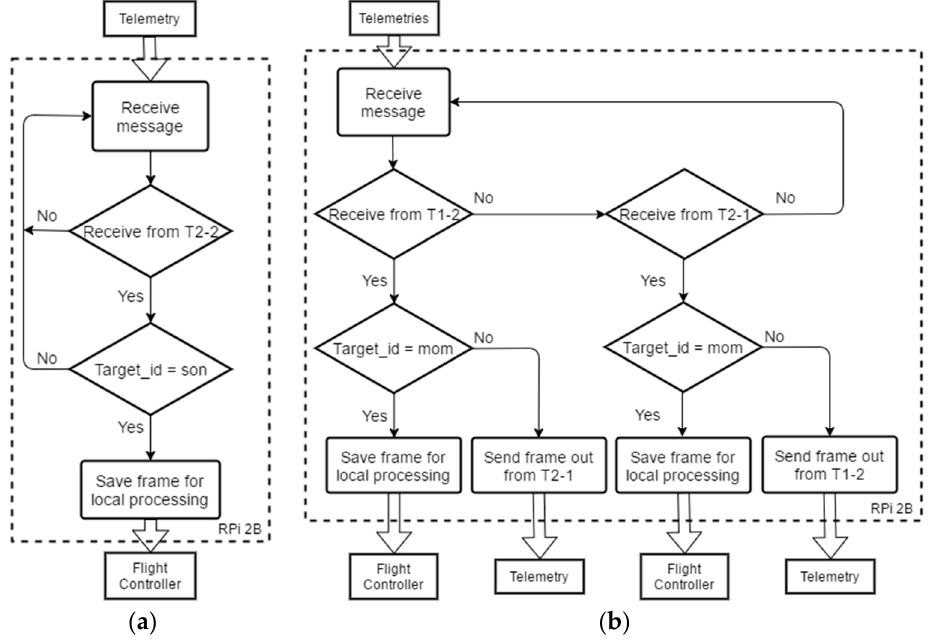
Figure 12. Flow chart of mission control software for ( a ) UAV “Son” and ( b ) UAV “Mom”.